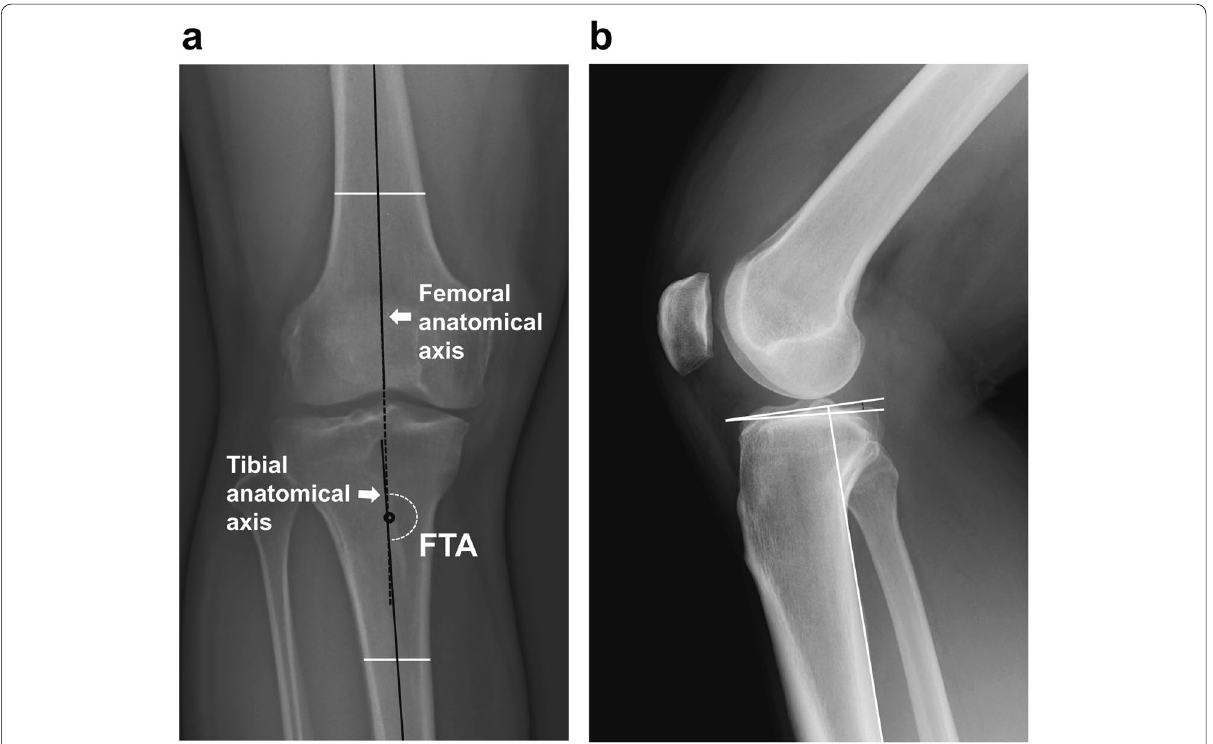
Fig. 1 Femorotibial angle and posterior tibial slope measurements. a The femorotibial angle (FTA) is formed by two axes. The femoral anatomical axis originates from the femoral intercondylar notch point, and the tibial anatomical axis originates from the tibial plateau center. b The posterior tibial slope (PTS) was measured as the angle between the tangent to the medial tibial plateau and a line perpendicular to the posterior tibial